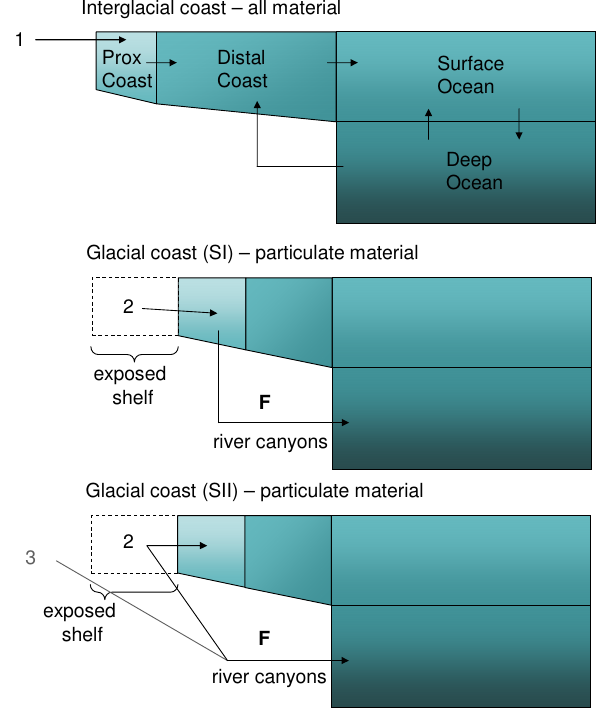
Fig. 1. Path of material in the coastal and open ocean during glacia- tions. Transfer of dissolved material, such as dissolved riverine P (1), always remains the same. Particulate material can become rerouted directly to the deep-sea by submarine canyons via tur- bidites or other gravity flows. In rerouting scenario SI a proximal zone remains to rework and trap material arriving from the conti- nent. River canyons (fraction F) then shunt material from the prox- imal coast to the deep-sea, bypassing the distal coast. In rerouting scenario SII, the entire coast is bypassed and major rivers (frac- tion F) discharge directly to the deep-sea (3). Additionally surface sediment on exposed shelves can erode into the coastal ocean (2). This sediment represents labile marine organic matter deposited during previous interglacial stages. We assume it contains 2% or- ganic carbon by weight and a C/P ratio of 300. Where river canyons form, this sediment is also shunted to the deep-sea along with the continental particulate